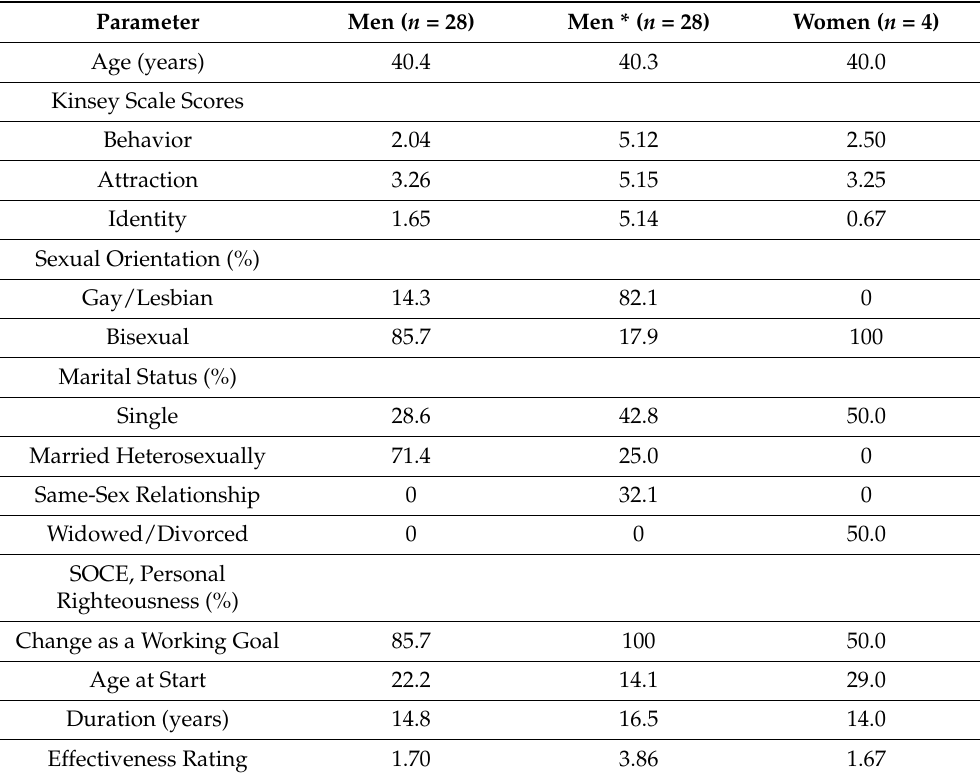
Table 3. Respondents Claiming Orientation